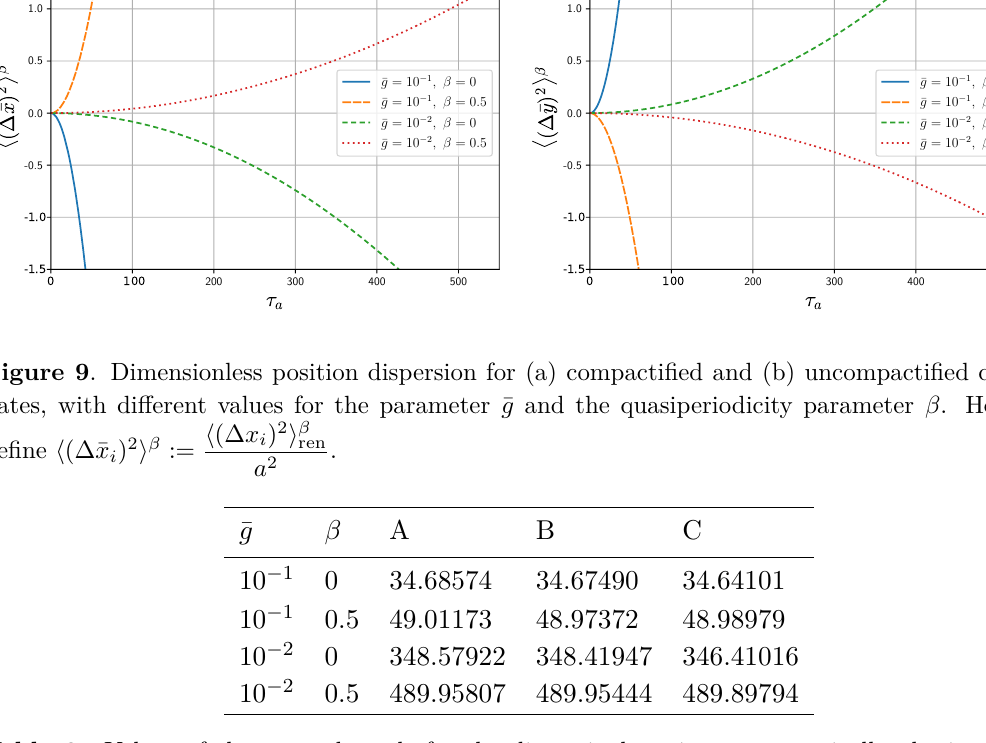
Table 2 . Values of the upper bounds for the dimensionless time τ a numerically obtained from figure 9 for the compactified direction, column A, uncompactified direction, column B, and provided by condition (3.50), column